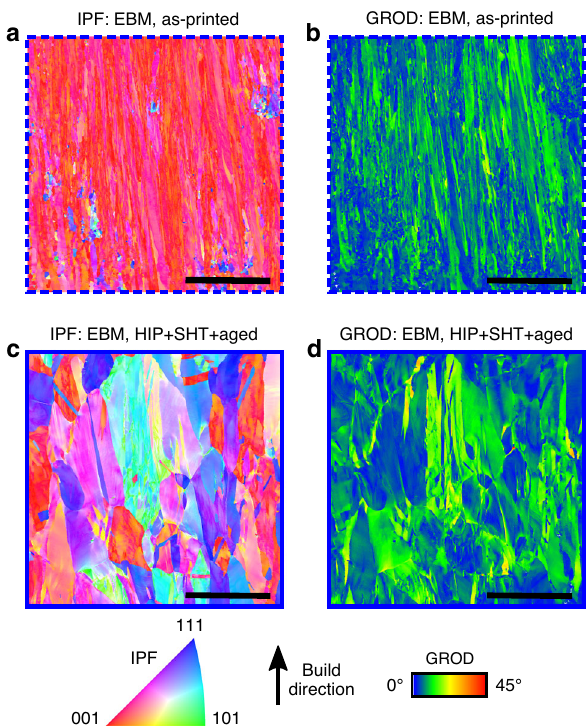
Fig. 7 EBSD of post-mortem EBM tensile specimens. a , c IPF maps and b , d grain reference orientation deviation (GROD) maps show the accumulation of plastic strain after tensile testing of the EBM material in the a , b as-printed and c , d HIP + SHT + aged conditions. The scale bars are 500 μ